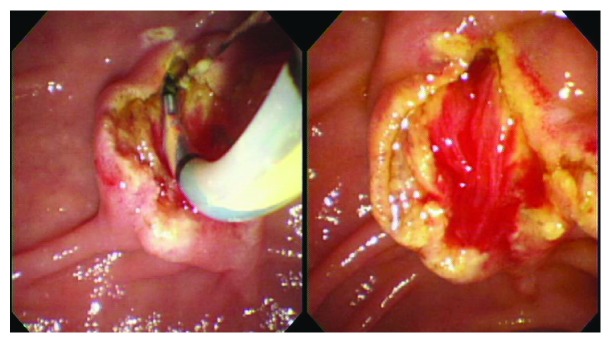
Complete endoscopic sphincterotomy was performed.